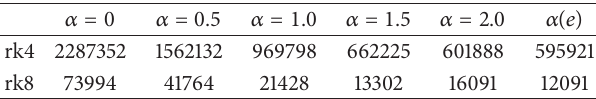
Table 3: Number of steps to get a precision of |Δ ⃗𝑟| < 10 −4 Km. 𝛼 = 0 𝛼 = 0.5 𝛼 = 1.0 𝛼 = 1.5 𝛼 = 2.0 𝛼(𝑒) rk4 2287352 1562132 969798 662225 601888 595921 rk8 73994 41764 21428 13302 16091